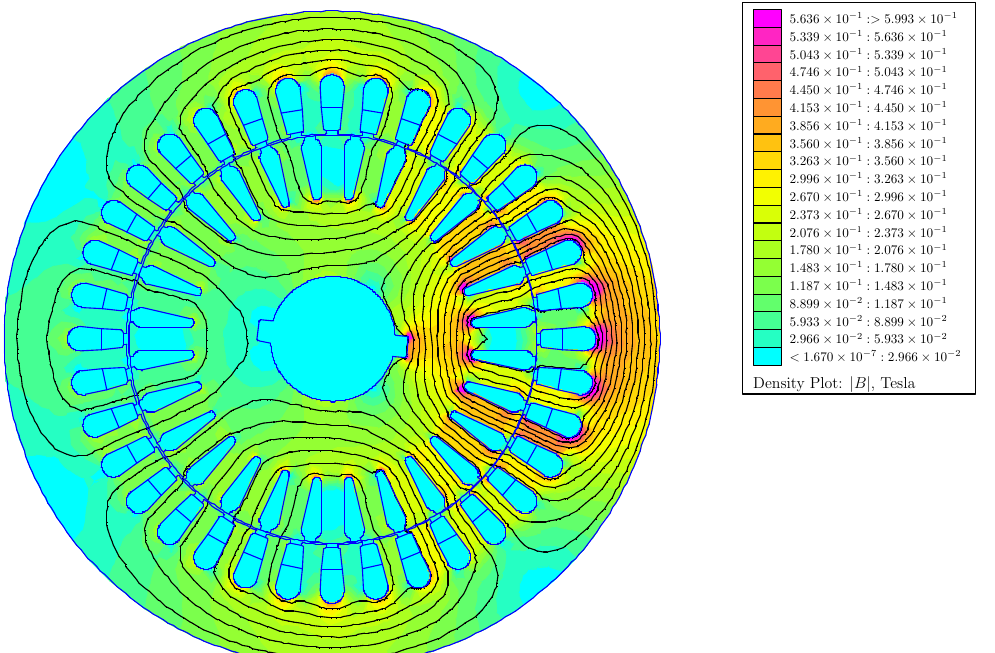
Figure 15. FEM simulation of the IM of Appendix A for a mixed eccentricity with a static eccentricity degree of 40% ( δ s = 0.4) and a dynamic eccentricity degree of 20% ( δ d = 0.2), with only the first stator phase fed with a 1 A constant current.